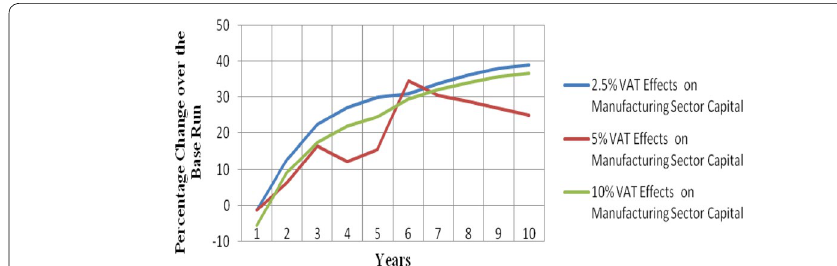
Fig. 31 Changes in capital stock in manufacturing